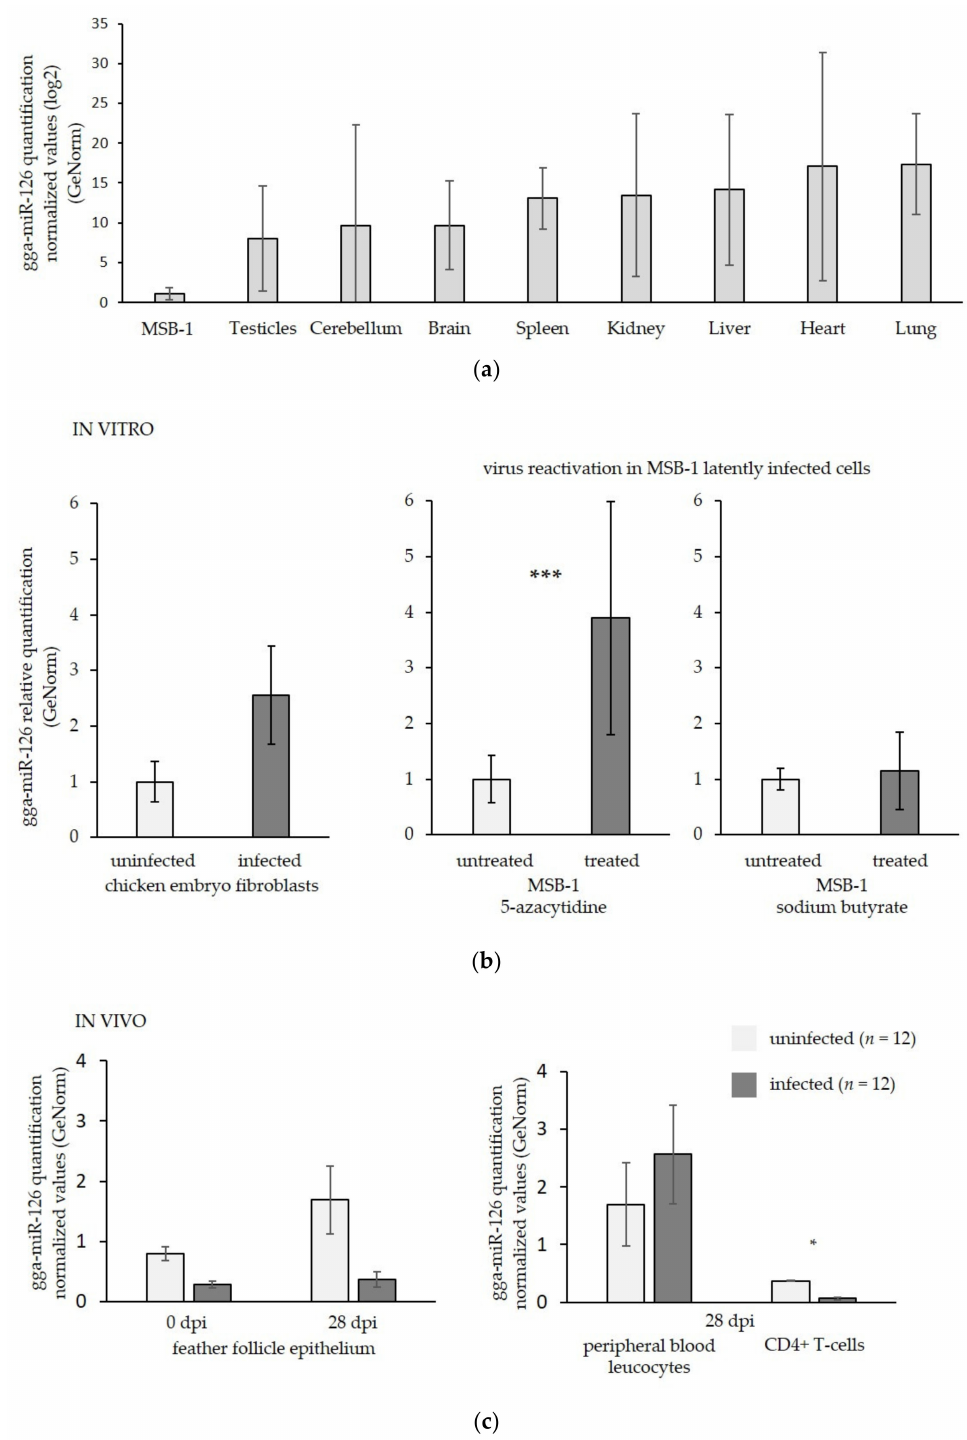
Figure 1. MiR-126 quantification in in vitro and in vivo samples. ( a ) Quantification of miR-126 in eight organs (brain, cerebellum, heart, lung, spleen, liver, testicle, and kidney) from three uninfected chicken and in a MSB-1 cell line by qRT-PCR; ( b ) quantification of miR-126 in in vitro samples representing the different phases of the viral life cycle of GaHV-2 (two independent assays with technical triplicates); ( c ) quantification of miR-126 in in vivo samples. Uninfected or untreated samples are represented in light grey. Infected or treated samples are represented in dark grey. In all the graphs, the X-axis represents the samples used for quantification, and the Y-axis represents normalized values with three reference genes ( GAPDH, HMBS, 18S rRNA ) selected by GeNorm software. Student’s t -test: *, p < 0.05; ***, p < 0.001 represent significant results. Error bars are standard